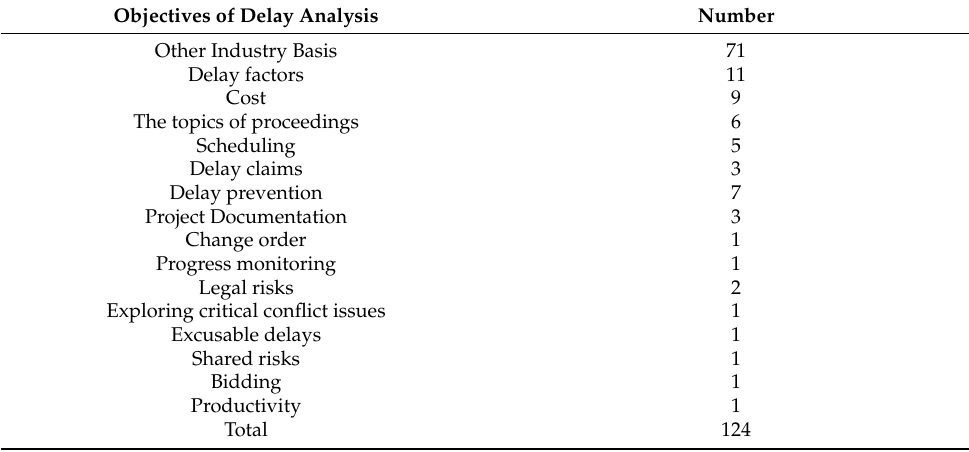
Table 1. Categorization of objectives of omitted documents obtained from Scopus Database and Web of Science